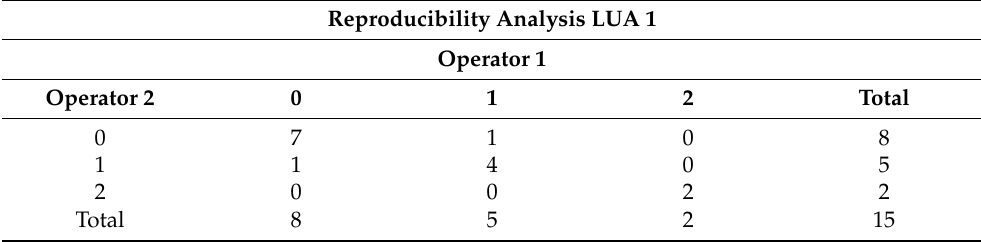
Table 7. Number of lung ultrasound areas interested by lung ultrasound alteration 1 (LUA1) found by operator 1 and 2.